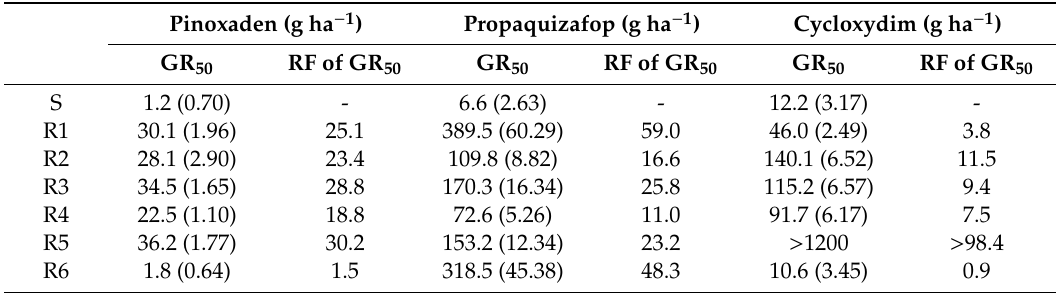
Figure 4. Dose-response curves for survival ( A ) and shoot dry weight ( B , C ) of susceptible (S) and test populations (R1 to R6) of A. fatua treated with a range of dose rates covering from 0.25 × to 8 × recommended field rate of cycloxydim. Arrows indicate the recommended field rate of 150 g cycloxydim ha − 1 for A. fatua control. Table 3. Shoot dry weight GR 50 (standard errors in parentheses) of susceptible (S) (mean values of S1 and S2) and test populations (R1 to R6) of A. fatua treated with a range of ± recommended field rate of rate of cycloxydim 150 g ha − 1 . Resistance factor (RF) was calculated as the ratio of GR 50 values of test and susceptible